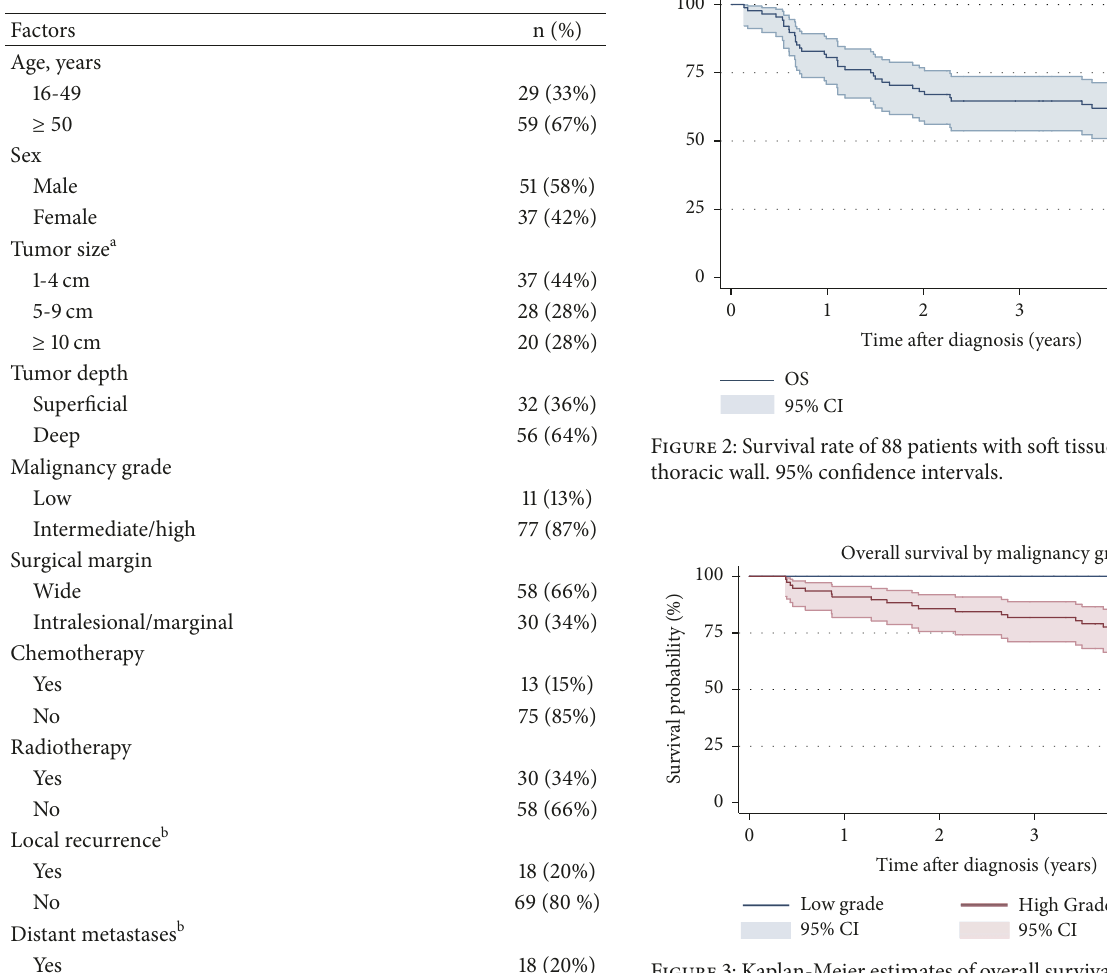
Table 1: Patient, tumor, and treatment characteristics.